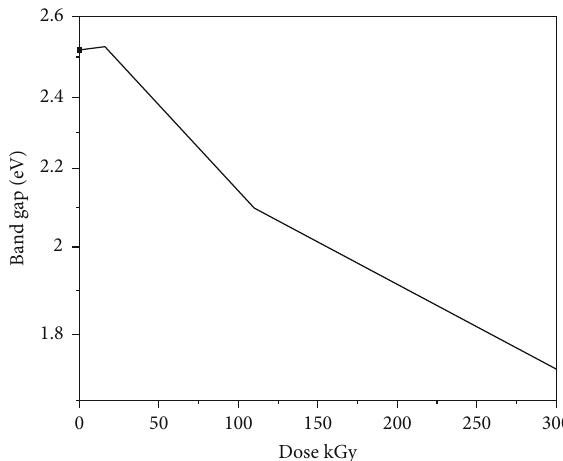
Figure 3: Di ff erence of band gap with radiation dose of UHMWPE polymer.